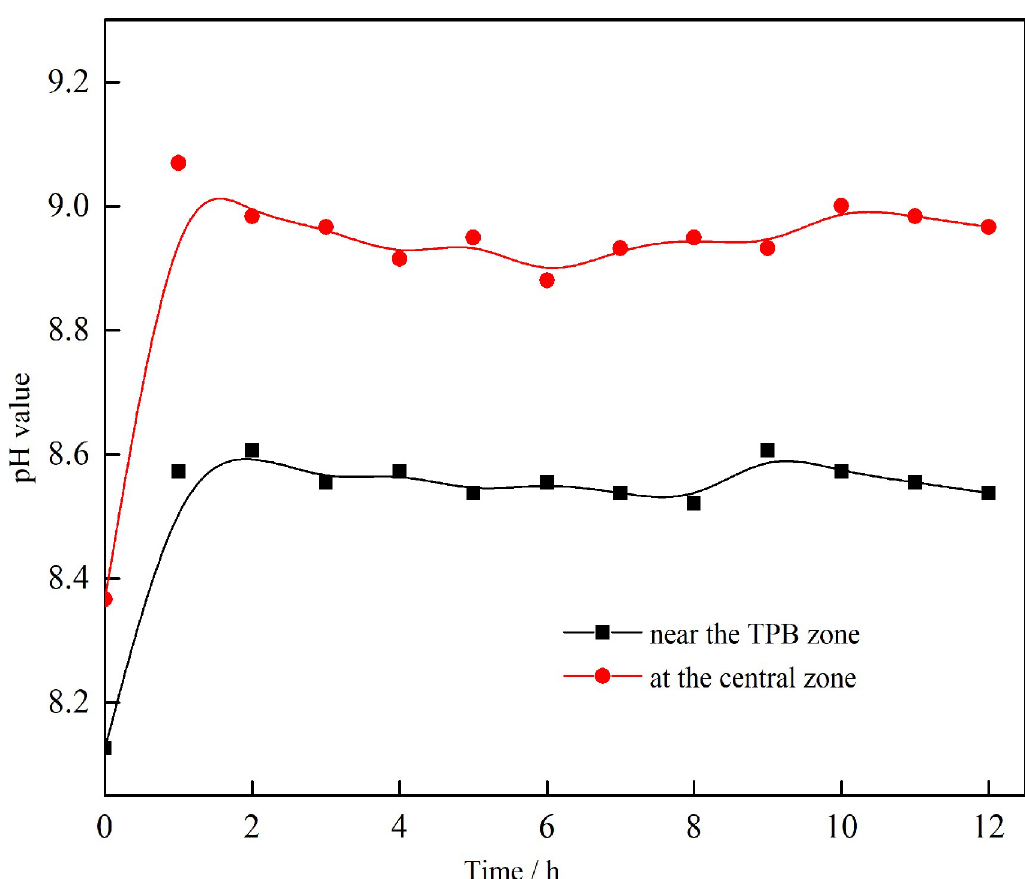
Fig 6. Variations of pH values with the exposure